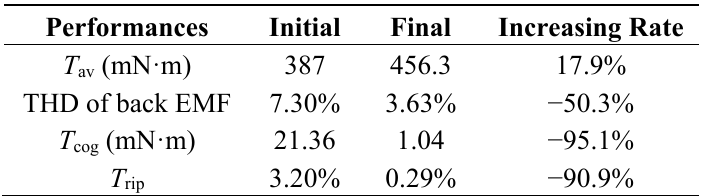
Figure 9. Comparison of electromagnetic performance of before and after optimization: ( a ) no-load back EMF waveform; ( b ) torque waveform. Table 13. Comparison